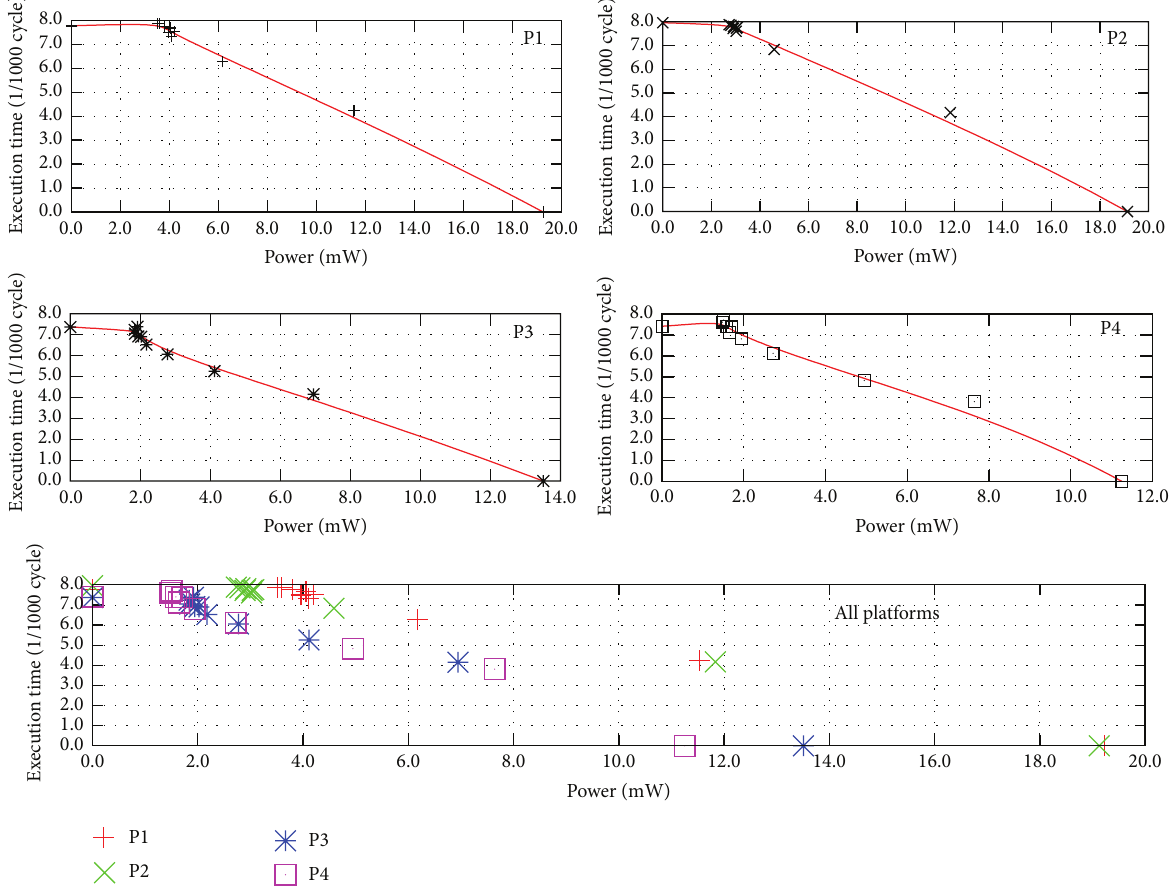
Figure 15: Aggregated Pareto front (time versus power) for synthesized benchmark (S2).